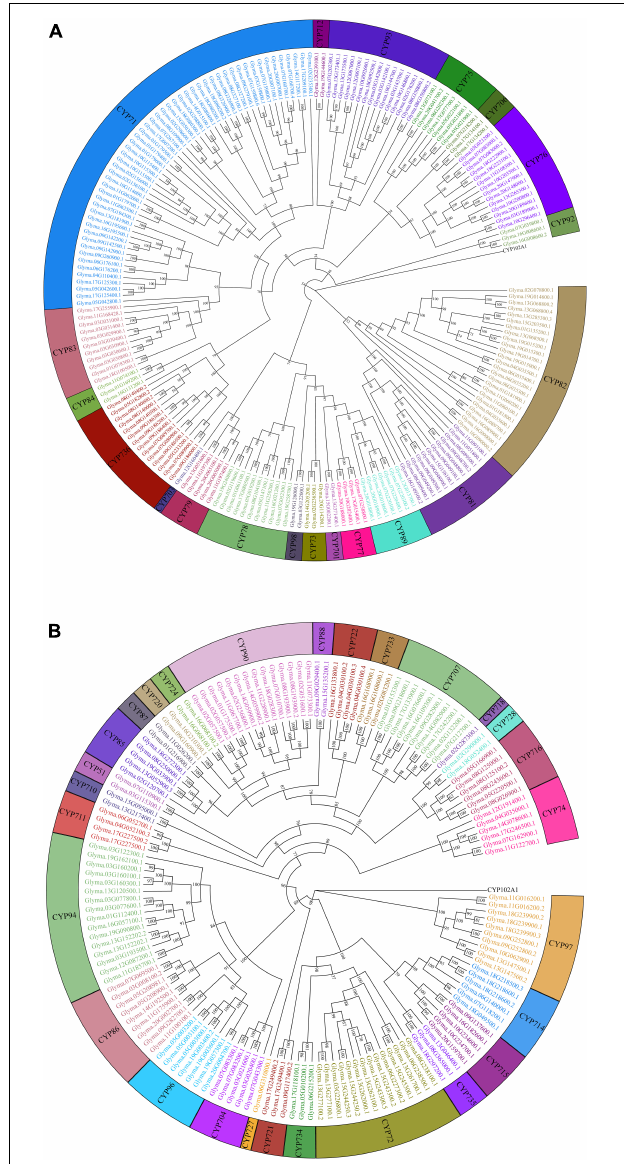
FIGURE 2 | Phylogenetic analysis of GmP450s. Amino acid sequences of GmP450s were aligned in ClustalO and a phylogenetic tree was constructed using a maximum likelihood method in IQTREE2 with best fit model with a bootstrap value set to 1,000. CYP102A1 indicates an out-group used to root the tree. (A) A-type, and (B) non-A-type